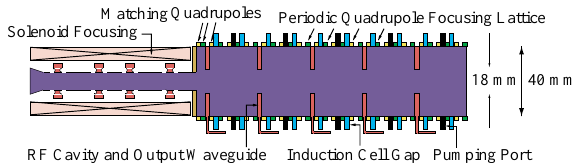
FIG. 2. (Color) Modulation and extraction section in RTA device.